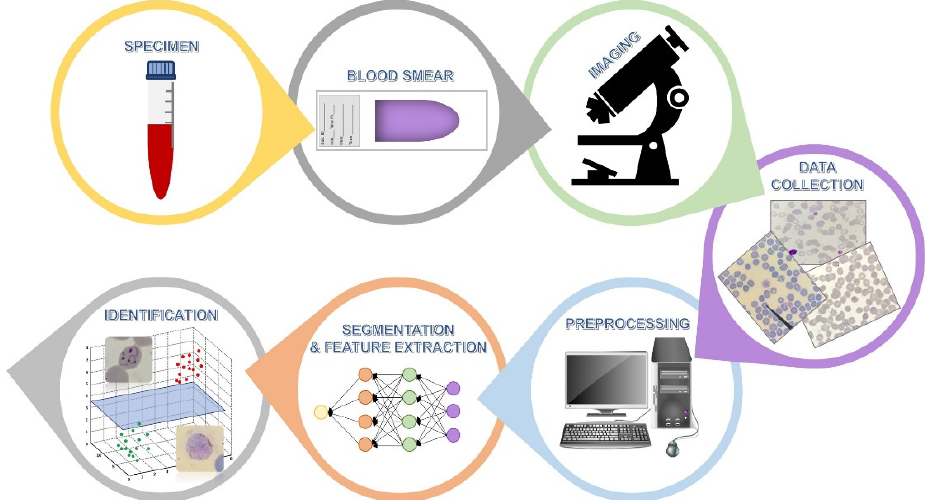
Figure 4. Malaria diagnosis by artificial intelligence technology. After performing a blood smear and staining, image acquisition, preprocessing, cell segmentation, feature extraction and selection, and parasite identification were performed. Several mathematic models and algorithms were applied to identify the Plasmodium species.